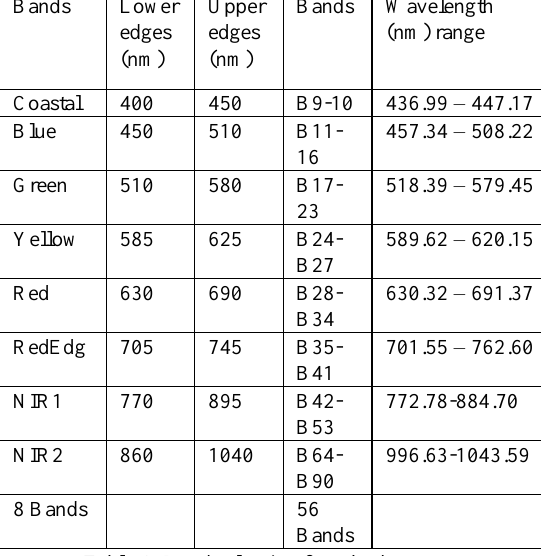
Table 1. Band selection from both sensor.